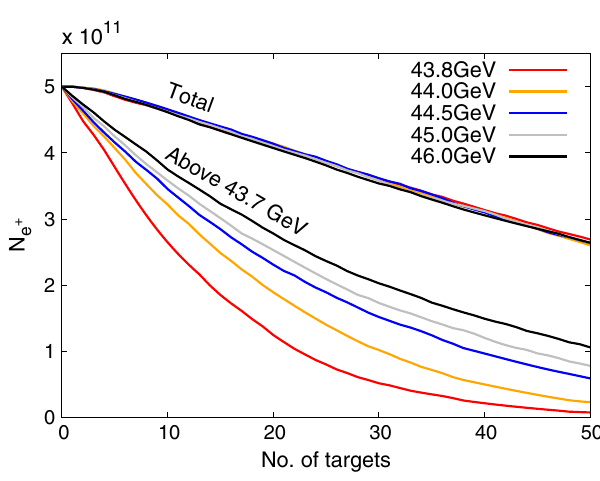
FIG. 7. Positron bunch population N e þ versus number of targets, 1% X 0 of Be each, for five different beam energies, counting only those above the muon production energy threshold at 43.7 GeV and the total population.